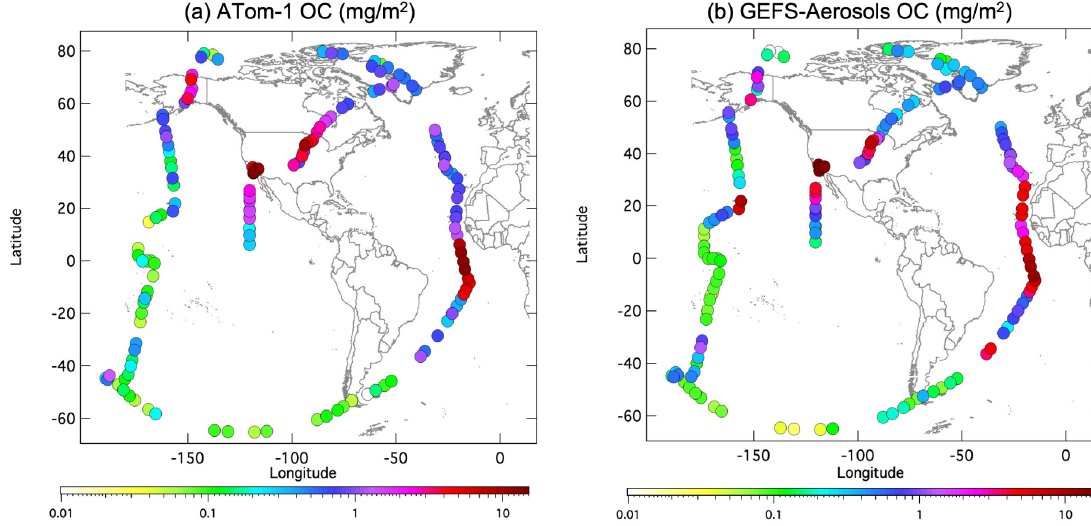
Figure 14. Tropospheric column sums of OC ( < 1.0µm diameter) for (a) ATom-1 DC-8 observations and (b) GEFS-Aerosols. Table 3. ATom-1 and GEFS-Aerosols column sum statistics of mean bias and correlation for sulfate, OC, BC, and dust. Species Obs.